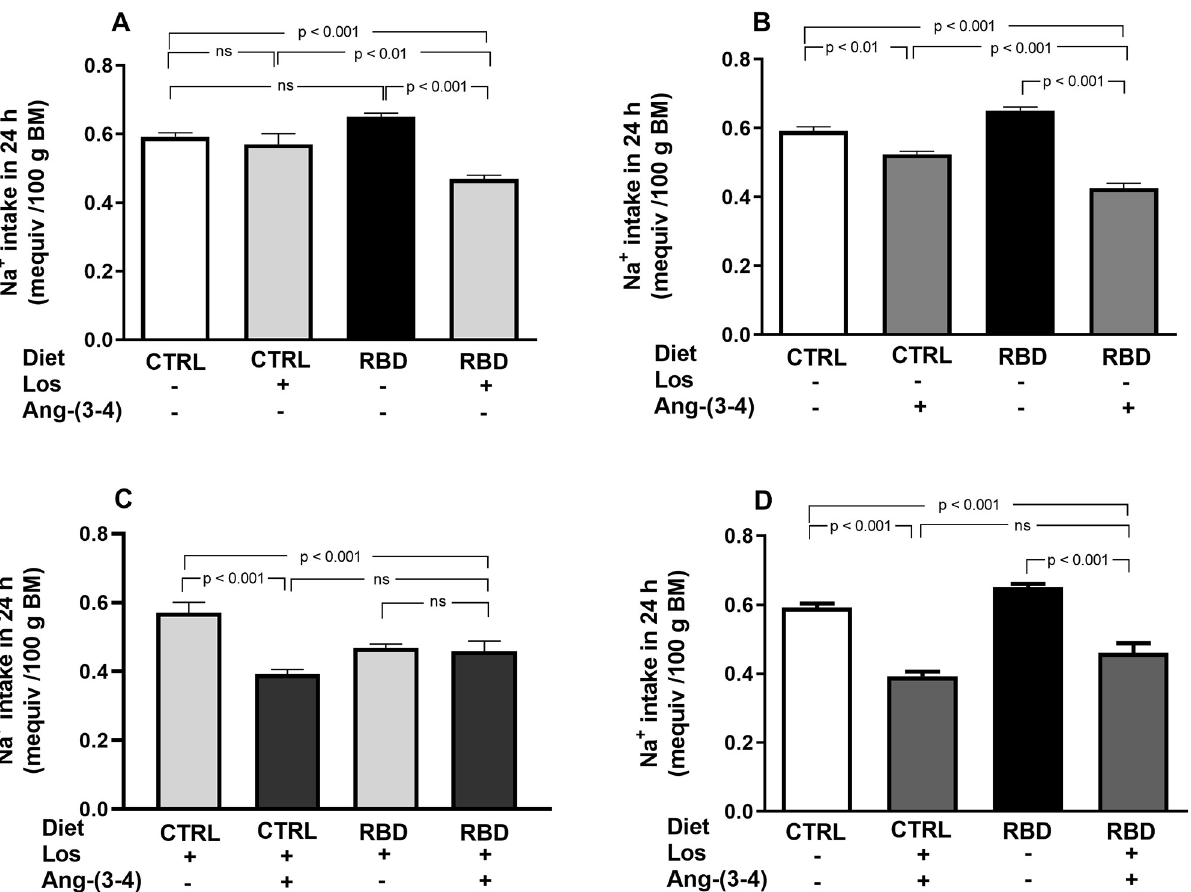
Fig 5. Na + intake. Na + intake in 24 h was calculated from the dietary Na + content and the food intake, measured between 90 and 91 days, except for Ang-(3–4)-treated rats which were measured at 91 and 92 days. (A) Responses to Losartan. Comparison of Na + intake by CTRL and RBD rats without chronic administration of Losartan, and effects of Losartan administration, as indicated on the abscissa . (B) Responses to Ang-(3–4). Effects of oral administration of a single dose of Ang-(3–4) on Na + intake by CTRL and RBD rats, as indicated on the abscissa . (C) Responses to Ang-(3–4) in rats previously treated with Losartan. Effects of oral administration of a single dose of Ang-(3–4) on Na + intake by CTRL and RBD rats previously treated with Losartan, as indicated on the abscissa . (D) Effects of combined Losartan+Ang-(3–4) administration. Comparison of Na + intake between untreated CTRL and RBD rats vs . CTRL and RBD rats that were chronically given Losartan and a single dose of Ang-(3–4), as indicated on the abscissa . Bars are mean ± SEM (data expressed per 100 g BM); n = 5 (CTRL), n = 8 (RBD), n = 5 (CTRL+Los), n = 6 (RBD+Los), n = 5 (CTRL+Ang-(3–4)), n = 8 (RBD +Ang-(3–4)), n = 5 (CTRL+Los+Ang-(3–4)), n = 6 (RBD+Los+Ang-(3–4)). Differences were assessed using one-way ANOVA followed by Bonferroni’s test for selected pairs. P values are indicated within the panels.